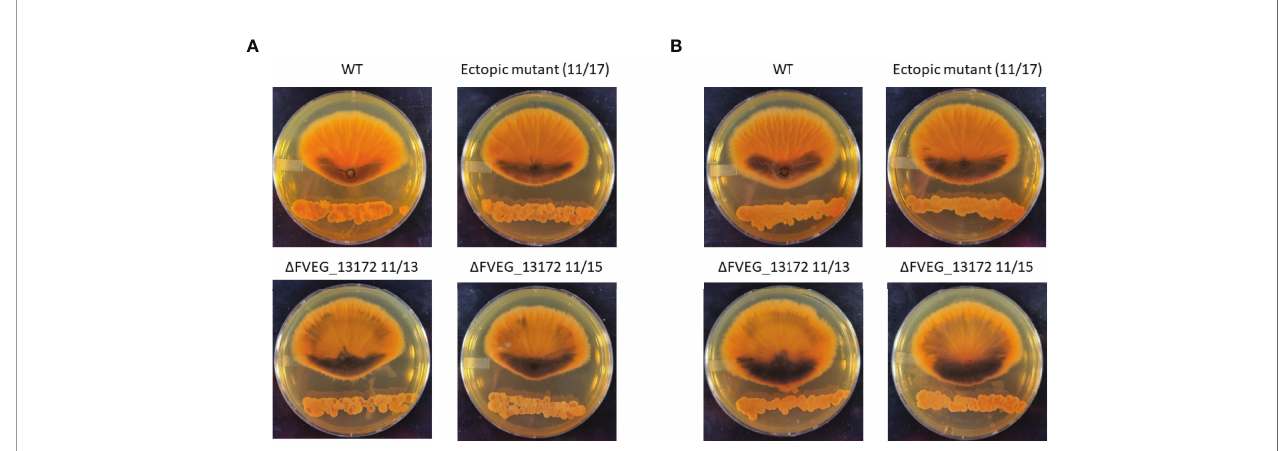
FIGURE 7 | Effect of D FVEG_13172 on inhibition caused by dual culture with Streptomyces strain s2831 or s2832. (A) Interactions of F verticillioides with s2831. (B) Interactions of F verticillioides with s2831 Streptomyces strain s2381 and s2832 were inoculated and grown for two days before inoculation with F verticillioides 25 mm from initial Streptomyces inoculation. The M3125 WT strain, two D FVEG_13172 strains (11/13 & 11/15) and one ectopic transformant (11/17) were used in this experiment. Images captured 7 days after fungal spore